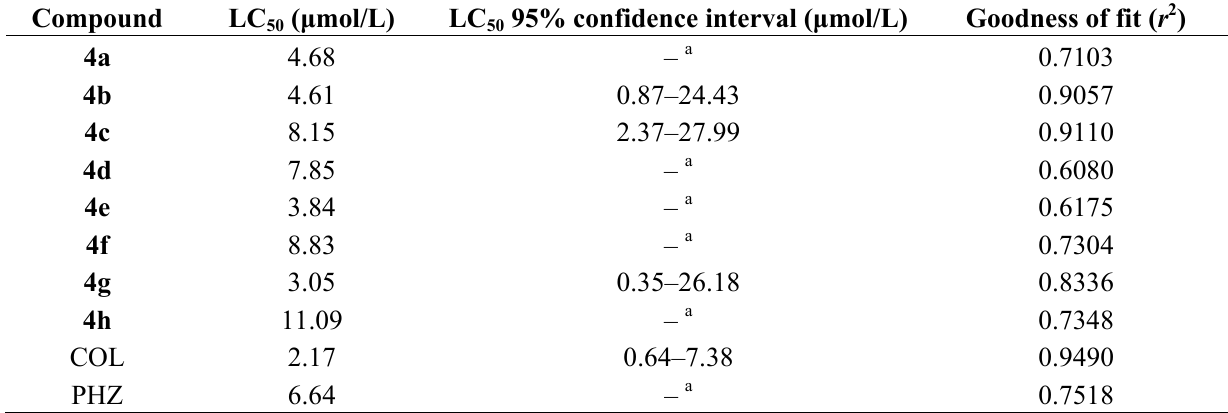
Table 1. The toxic activity of compounds 4a – h in the brine shrimp lethality bioassay.